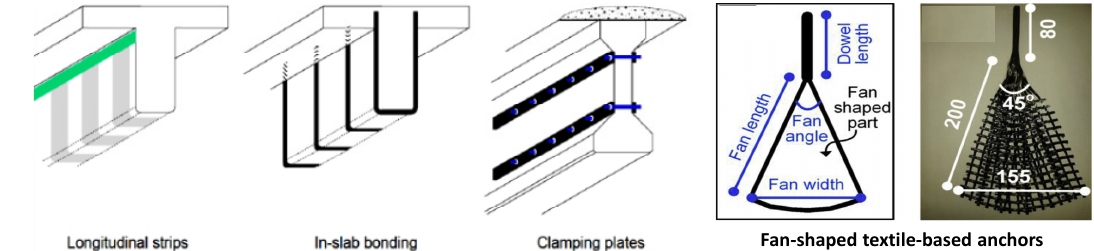
Fan-shaped textile-based anchors